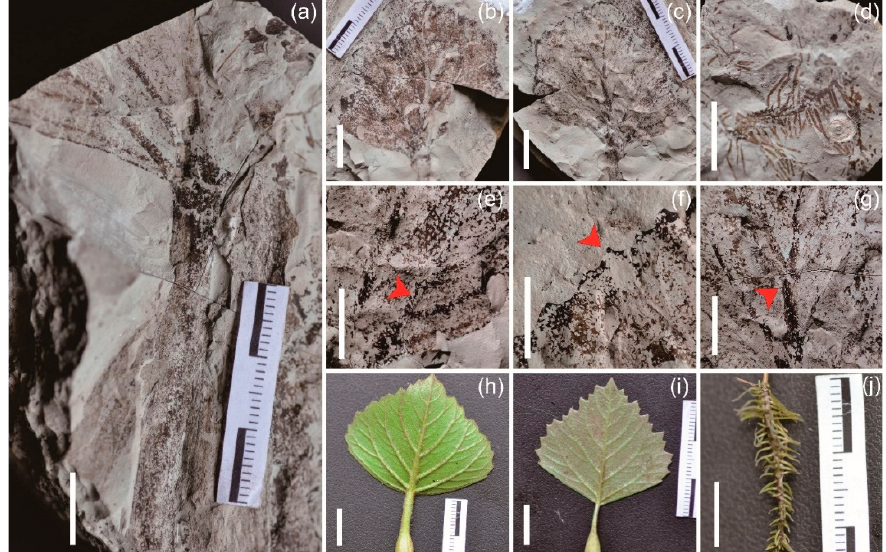
Figure 2. Fossil leaves of Trapa natanifolia Z. C. Han et H. Jia sp. nov and fossil roots of Trapa sp. and extant organs of Trapa L. ( a ) WN ‐ 0 ‐ 2 ‐ 57. ( b ) WN ‐ 0 ‐ 2 ‐ 6B. ( c ) WN ‐ 0 ‐ 2 ‐ 6A, holotype. ( d ) Fossil roots of Trapa sp. ( e ) Enlarged part of ( c ) showing secondary veins (red arrow). ( f ) Enlarged part of ( c ) showing the distal half of the margin coarsely dentate (red arrow). ( g ) Enlarged part of ( c ) showing an obvious midvein (red arrow). ( h , i ) Extant leaves of Trapa L. Scale bars = 10 mm. ( j ) extant root of Trapa L.